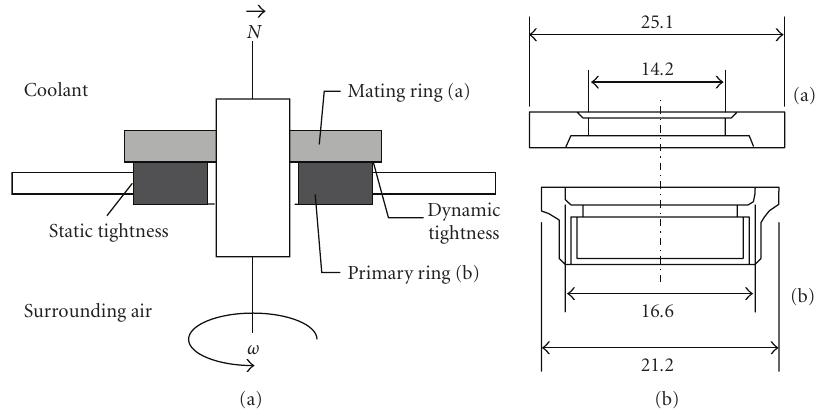
Figure 1: Friction test set-up and geometry and dimensions of the mating ring (a) and the primary ring